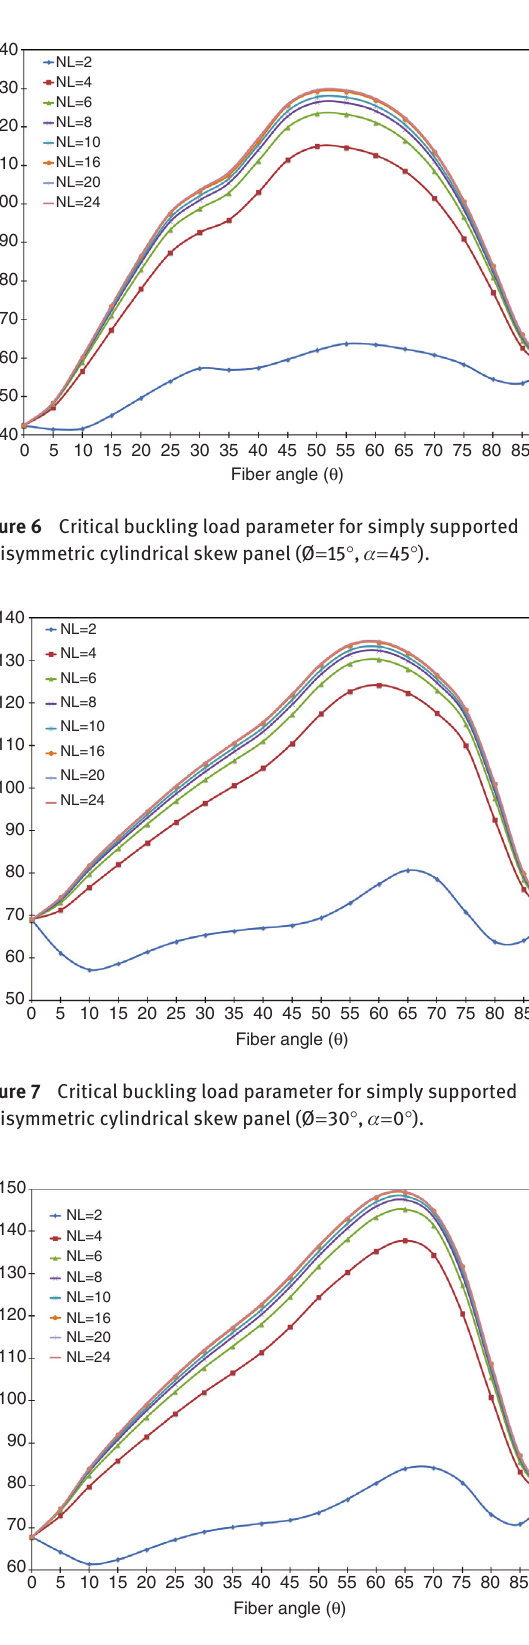
Figure 8 Critical buckling load parameter for simply supported antisymmetric cylindrical skew panel (Ø = 30 ° , α = 15 °